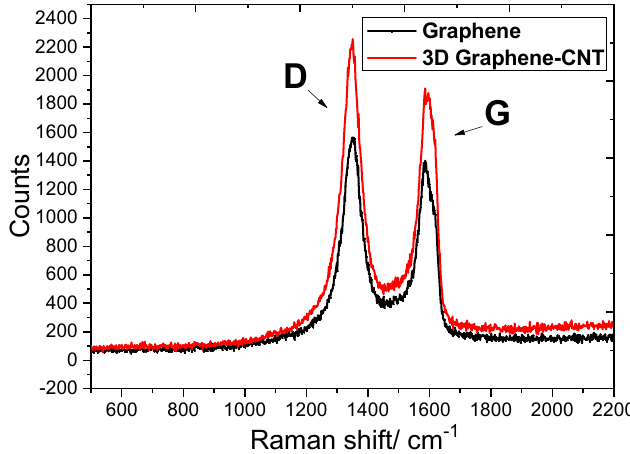
Figure 2. Raman spectra of Graphene network (I D /I G = 1.1) and 3D Graphene–CNT network (I D /I G = 1.2) with characteristic D and G peaks.